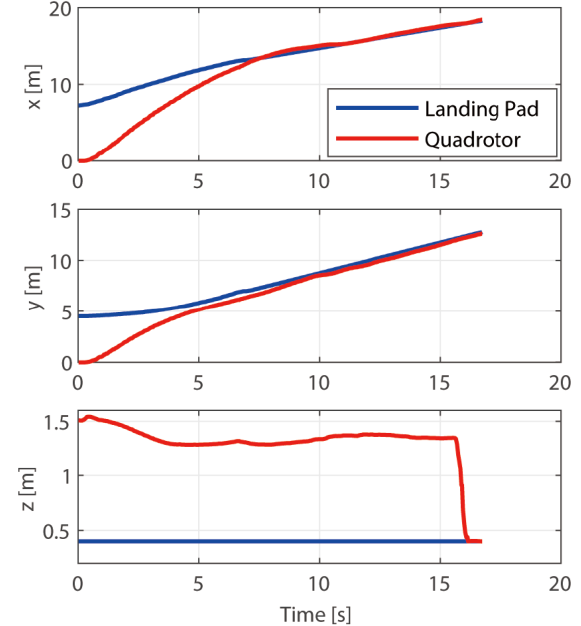
Figure 7. Trajectory of quadrotor and landing pad in case 1. ( a ) Trajectory with Gaussian noise with a standard deviation σ = 0.01. ( b ) Trajectory with Gaussian noise with a standard deviation σ = 0.5. ( c ) Trajectory with Gaussian noise with a standard deviation of σ = 1.0.